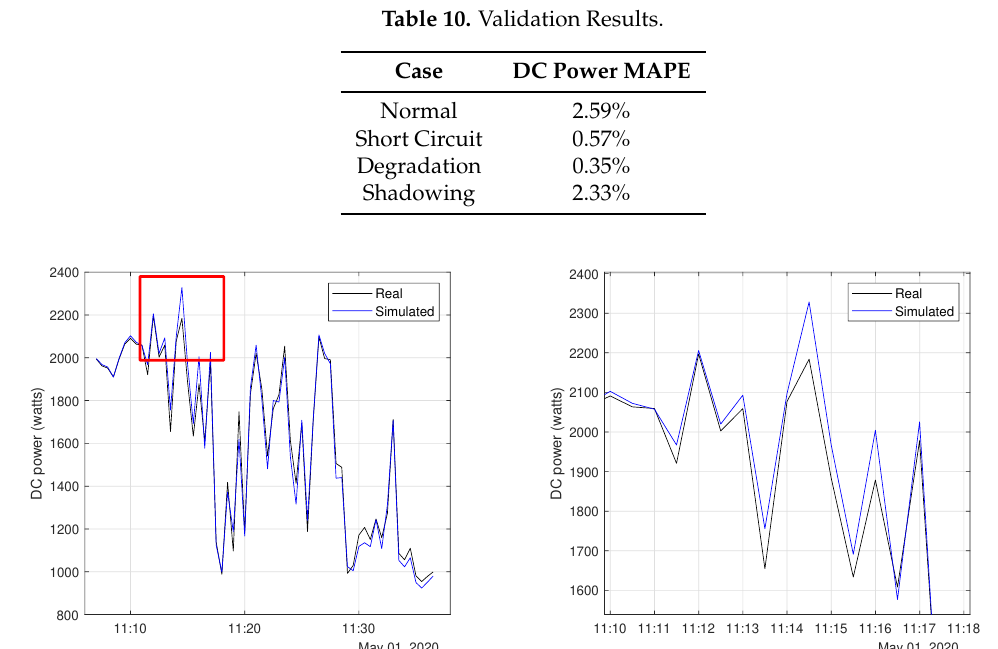
Figure 13. Comparison between simulated and real DC power output when the same irradiance ( G ) Figure 11: 2 Figures side by side and temperature ( T ) pairs are